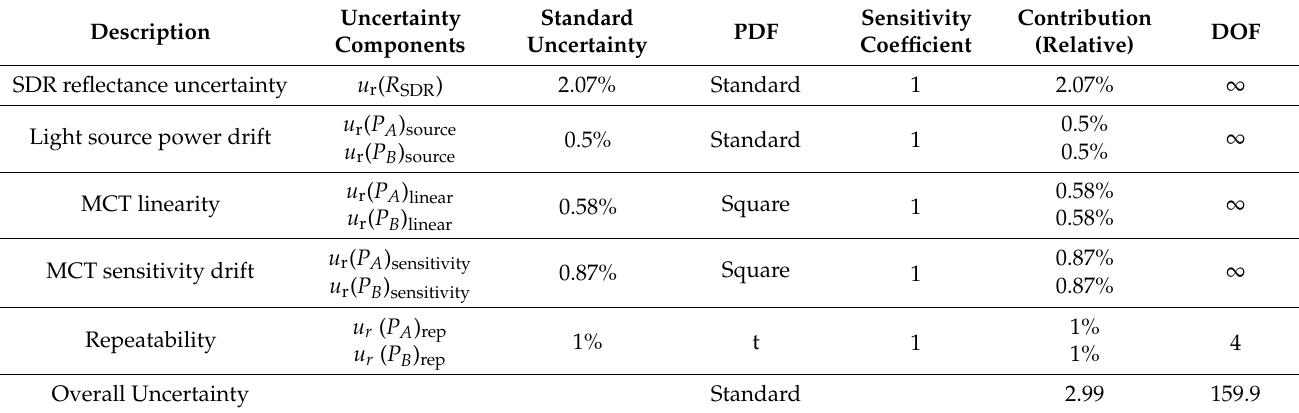
Figure 10. Spectral diffuse reflectance of three samples measured by the reflectometer for relative reflectance. Table 2. Uncertainty factors and evaluated overall relative uncertainty for relative reflectance measurement (ISW diffusivity is valid at 2 µ m; PDF: probability distribution function; DOF: degree of